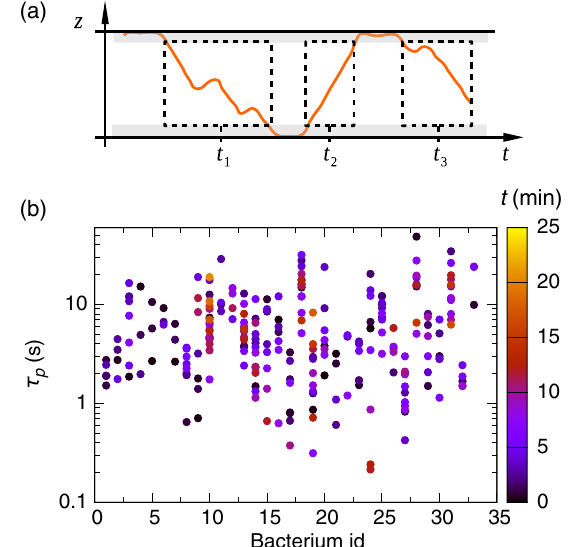
FIG. 4. Analysis for long tracks. Experiments II. (a) Sketch indicating the pieces of track from the same trajectory selected for demonstrating the behavioral variability. (b) τ p for pieces of track from the same trajectories, for 33 different RP437 bacteria in MB-S. The color represents the starting time of the measurement. Each bacterium displays a large variation of persistence